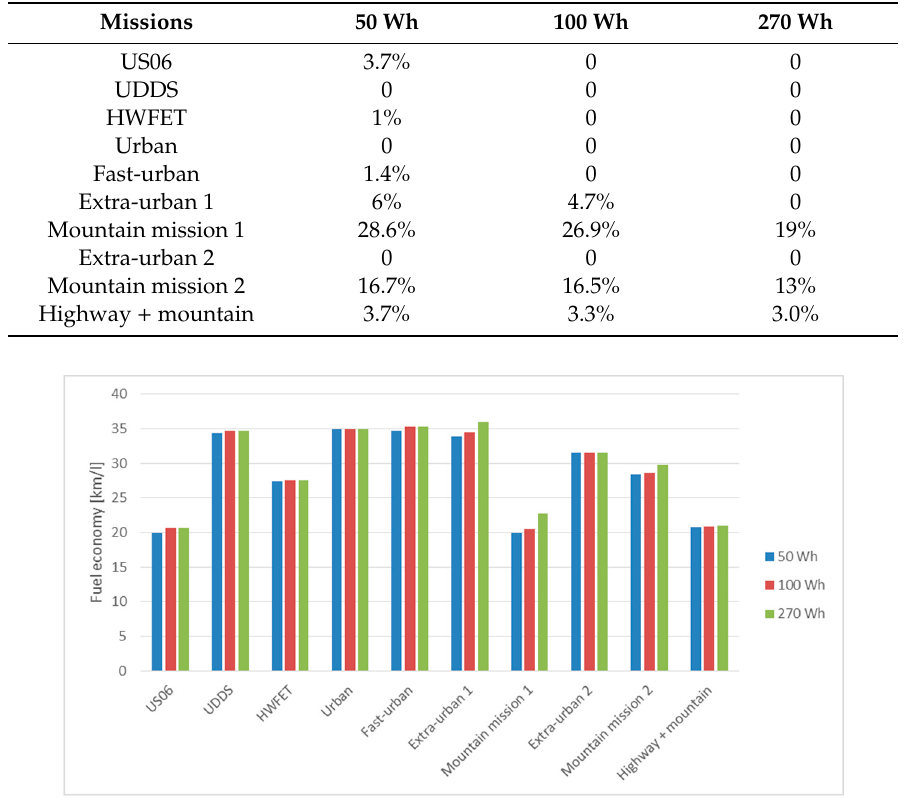
Figure 18. Fuel economy as a function of BZ sizing, spark-ignition engine.